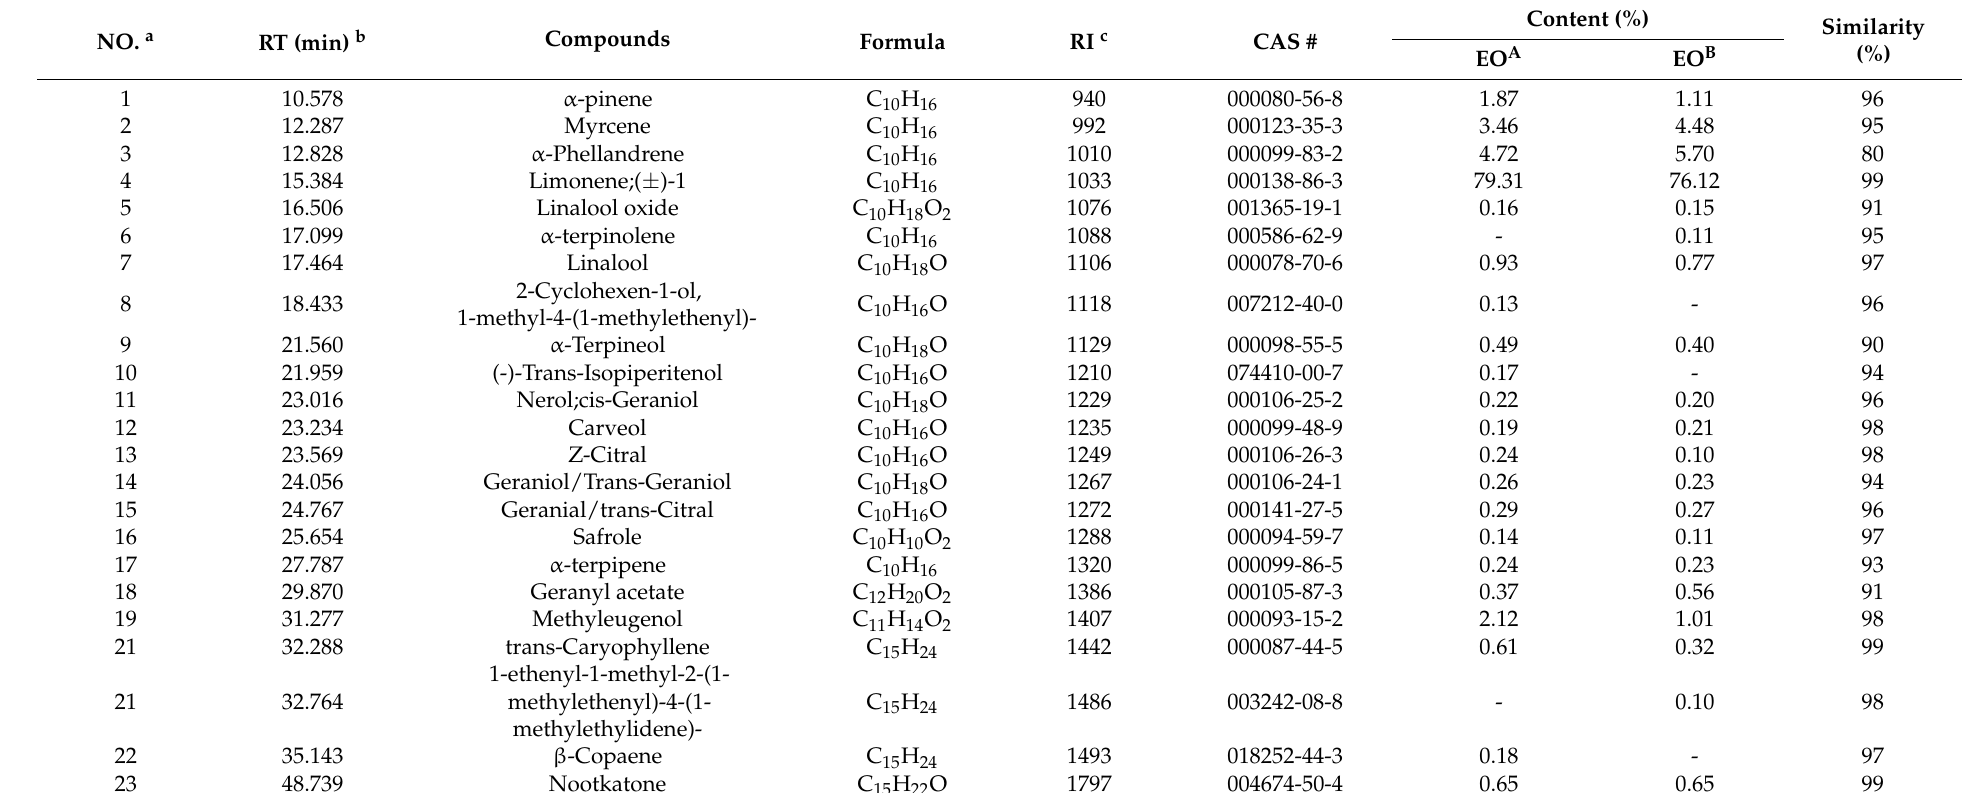
Table 3. Chemical constituents of essential oil from pomelo